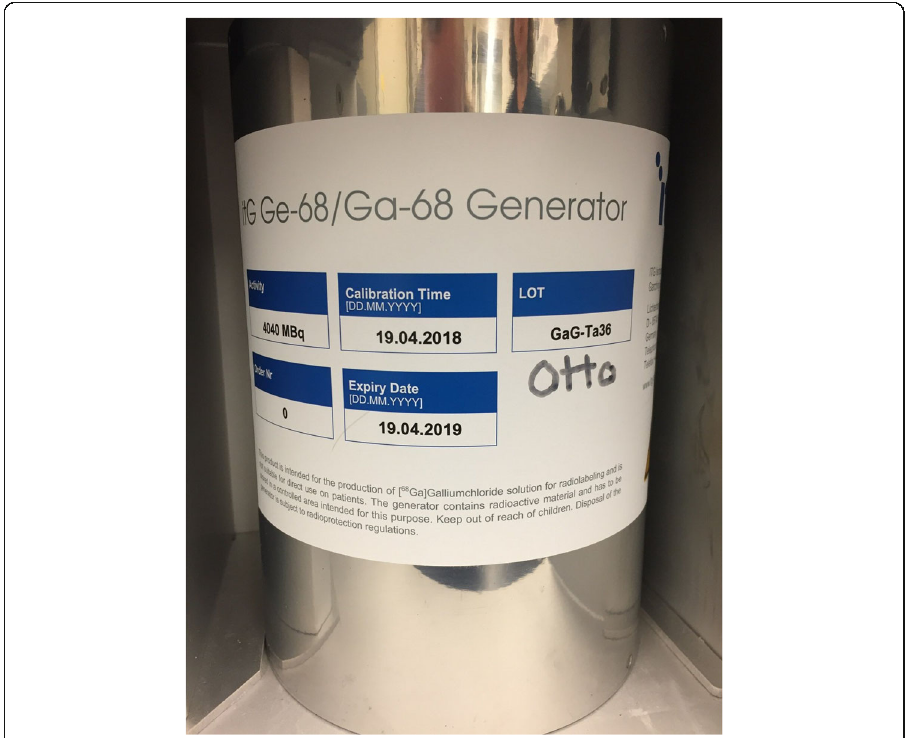
Fig. 1 Otto: itG GMP 4.04 Gbq (109 mCi at calibration on 04/19/2018) 68 Ge/ 68 Ga